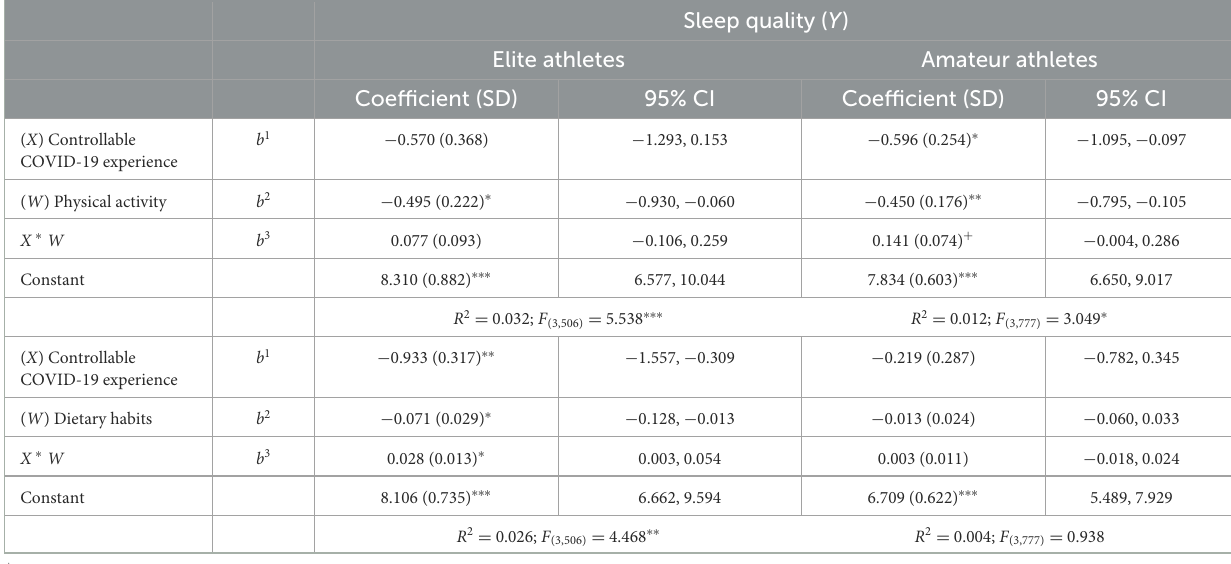
TABLE 4 Moderation analysis coefficients of physical activity and dietary